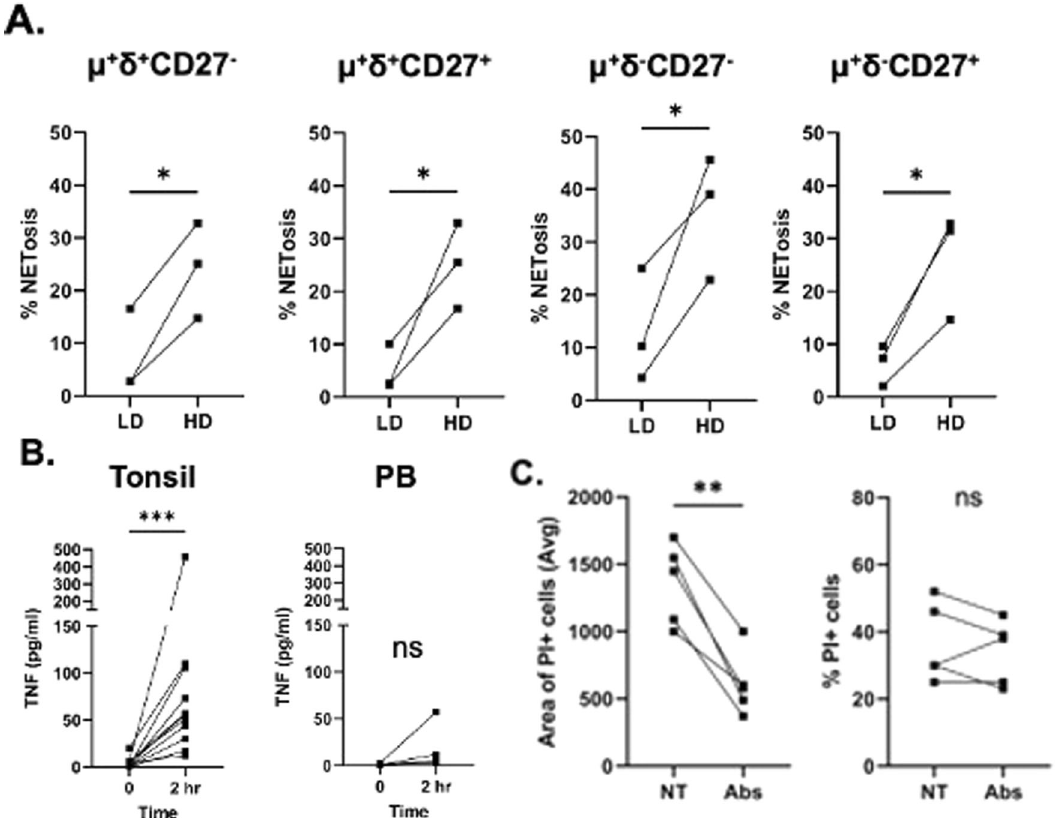
Fig. 3 Effect of cell density and secreted TNF on B cell death by NETosis. A Cells cultured at low density (LD) (5,000 cell/cm 2 ) versus high density (HD) (50,000 cell/cm 2 ). Paired t -test; * P < 0.05. B TNF secretion by tonsil and PB IgM + IgD + CD27 − B cells. TNF secretion in culture supernatant from cells killed abruptly by freezing or after 2 h incubation at 37 °C. Tonsil N = 11. T 0 = 2.5 pg/ml (median); 2 h culture = 56 pg/ml (median). PB N = 4. T 0 = 1.3 pg/ml (median); 2 h culture = 8.7 pg/ml (median). Wilcoxon test, Tonsil *** P < 0.001, PB P = 0.12. C Effect of TNF neutralizing Abs on B cell NETosis (left) and cell survival (right); Paired t -test, ** P =